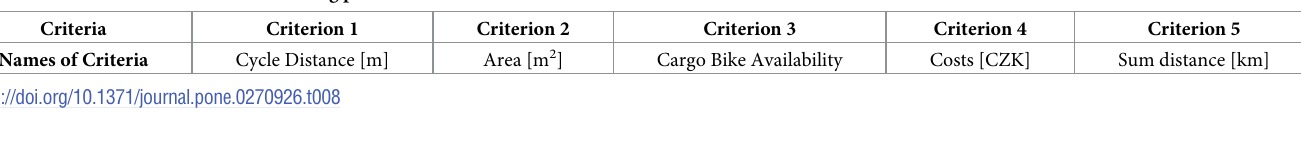
Table 9. Comparison of the best alternative to others.